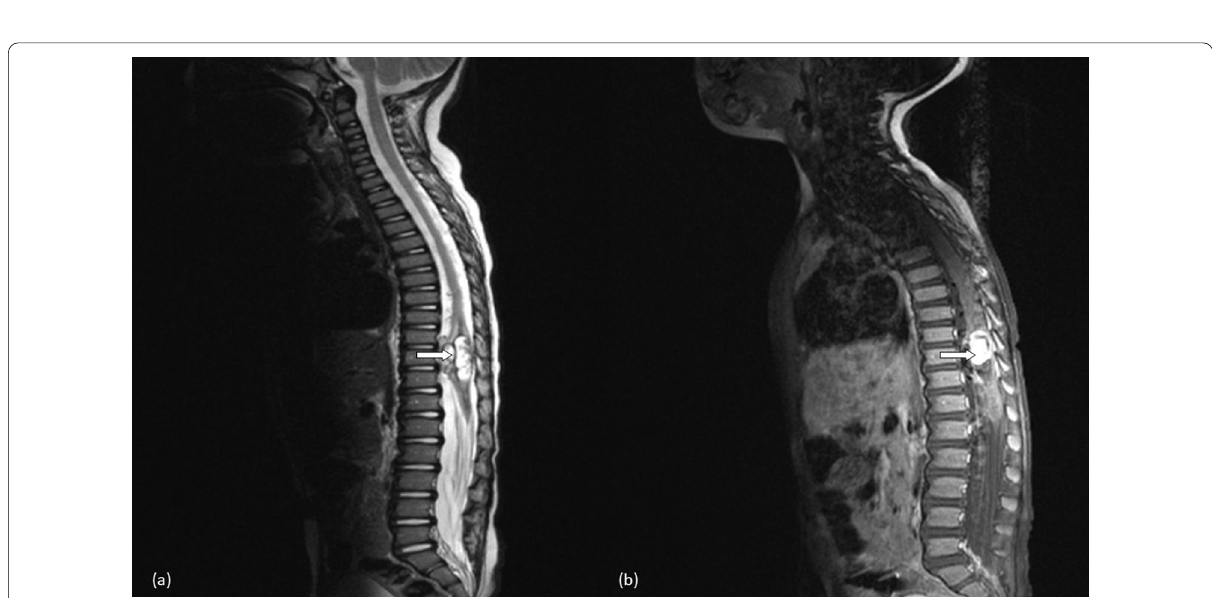
Fig. 3 Post-embolization a T2 weighted sagittal and b T1 weighted post-contrast Magnetic Resonance Imaging (MRI) images of the whole spine show regression of nidus at D9–D11 level (white arrows in a and b ) with the resolution of the cord edema seen in Fig.